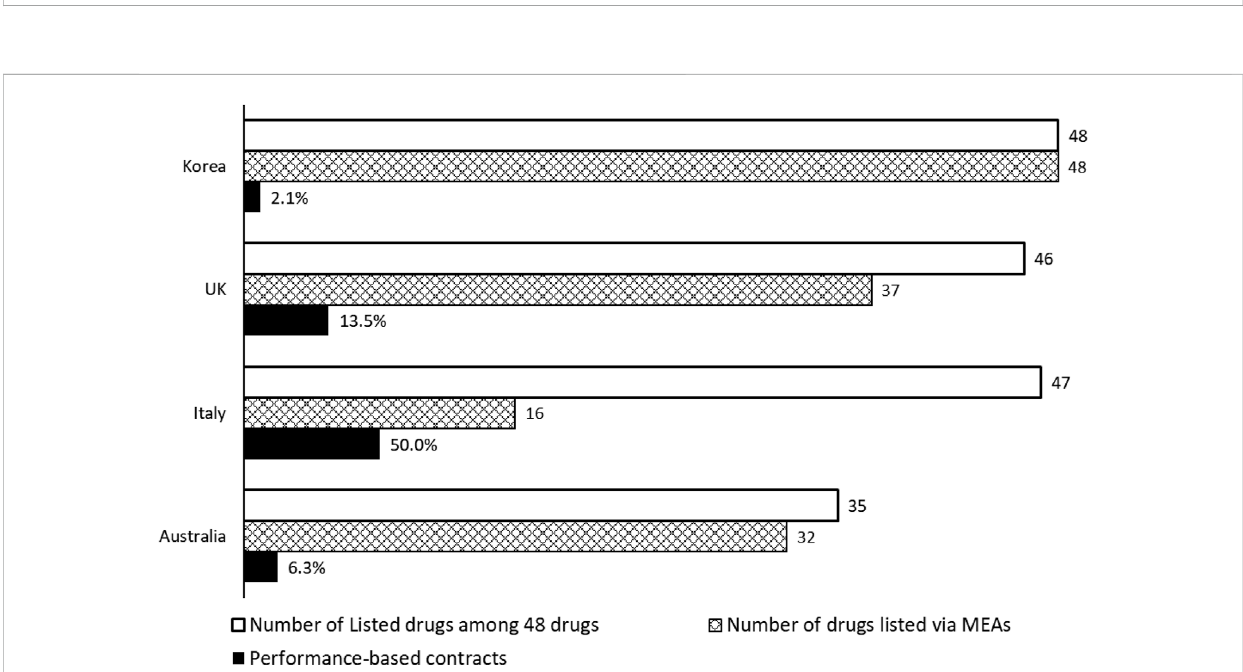
FIGURE 5 Comparison with the United Kingdom, Italy, and Australia for the 48